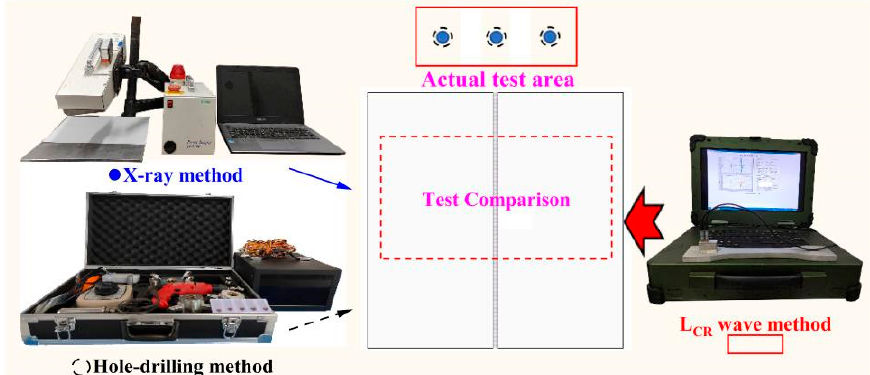
Simulation result of longitudinal residual stress distribution.